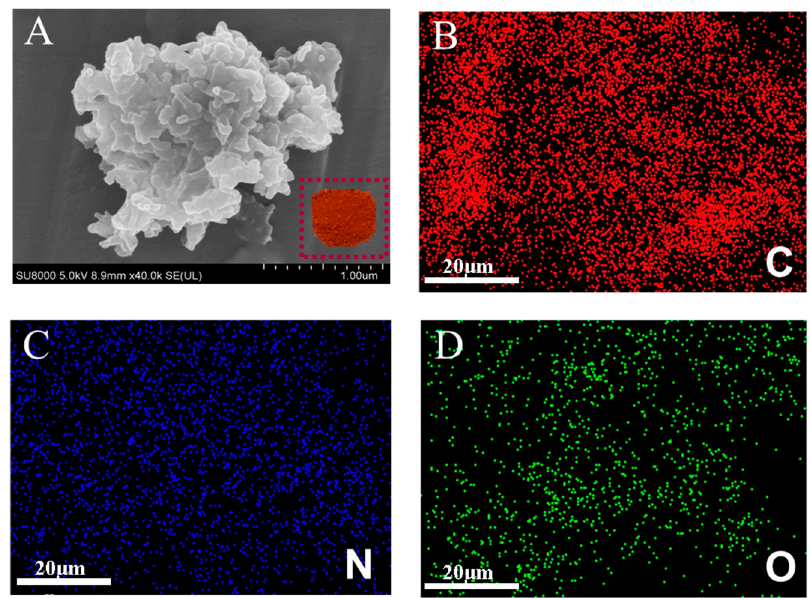
Figure 1. ( A ) SEM image of TpBpy COF (Insert: the picture of TpBpy COF). ( B – D ) EDS mapping of TpBpy COF.